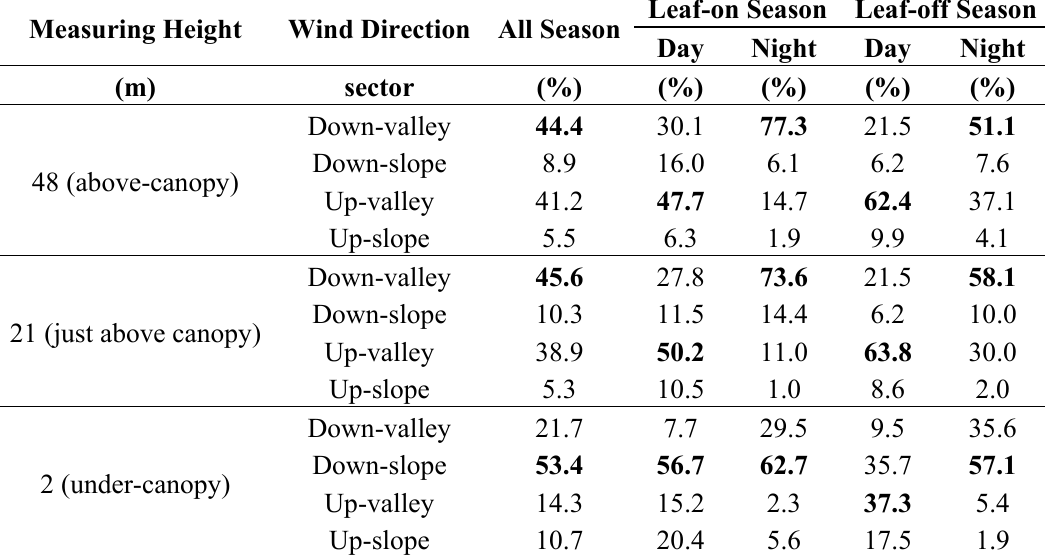
Table 2. Frequency of down- and up-valley, and down- and up-slope winds under the canopy, just above canopy and above canopy in the daytime and nighttime during the leaf-on and leaf-off seasons of 2012. The data are calculated using 30-min average wind vectors. The dominant wind directions are